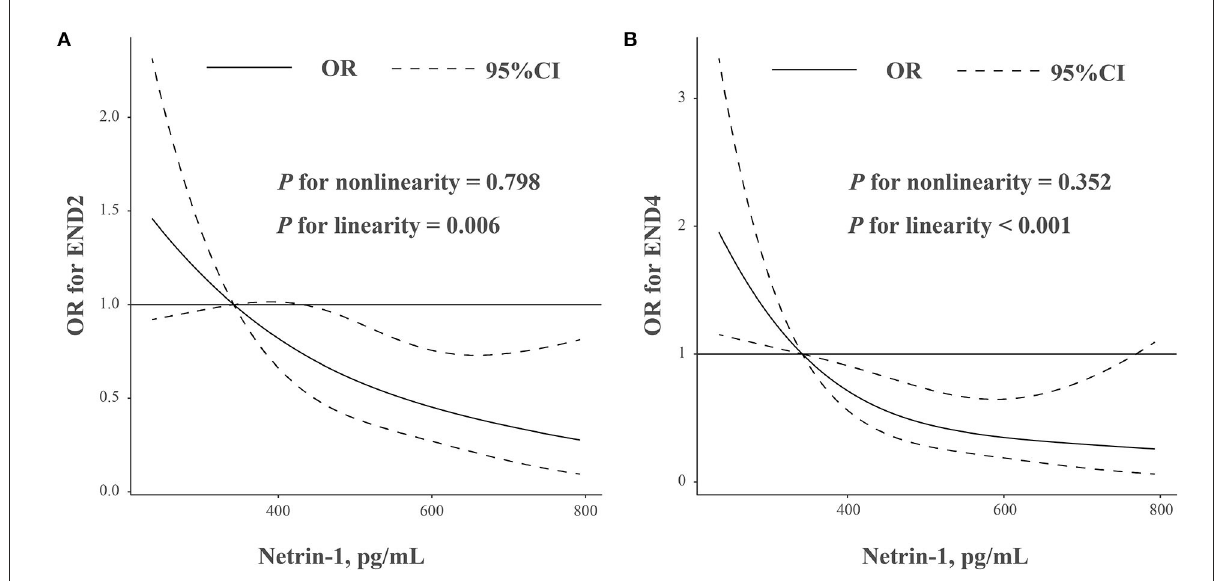
FIGURE1 (A,B) Association was fitted with a restricted cubic spline with 3 knots (at 5th, 50th, and 95th percentiles) adjusted for demographic characteristics, hypertension, baseline NIHSS score, baseline glucose levels, and hyper-sensitive C-reactive protein levels. The reference point for netrin-1 levels is 315.5 pg/ml (lowest quantiles of netrin-1 levels). CI, confidence intervals; OR, odds ratio.